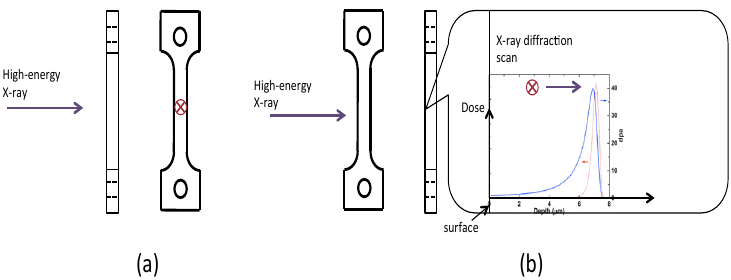
Figure 4. Schematic of the synchrotron experimental setup; the diffraction pattern in the schematic is from the bulk measurement of the un ‐ irradiated MA957 tensile specimen. Sample position (a) is for bulk measurement of the un ‐ irradiated MA957 tensile specimen; and sample position (b) is for X ‐ ray diffraction scan of the ion ‐ irradiated MA957 tensile specimen.